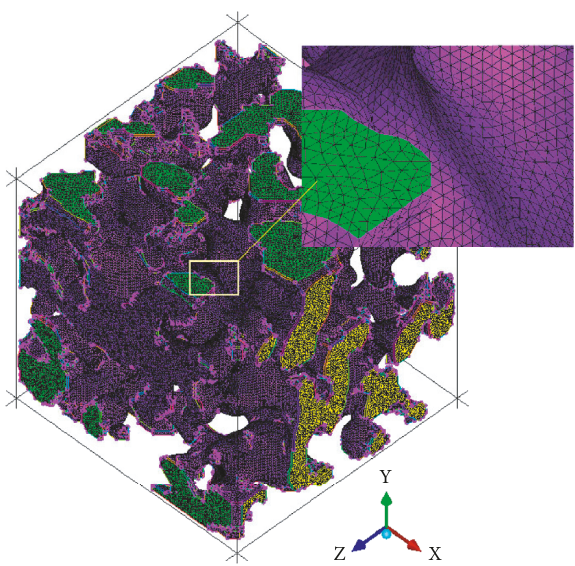
Figure 11: Grid generation.